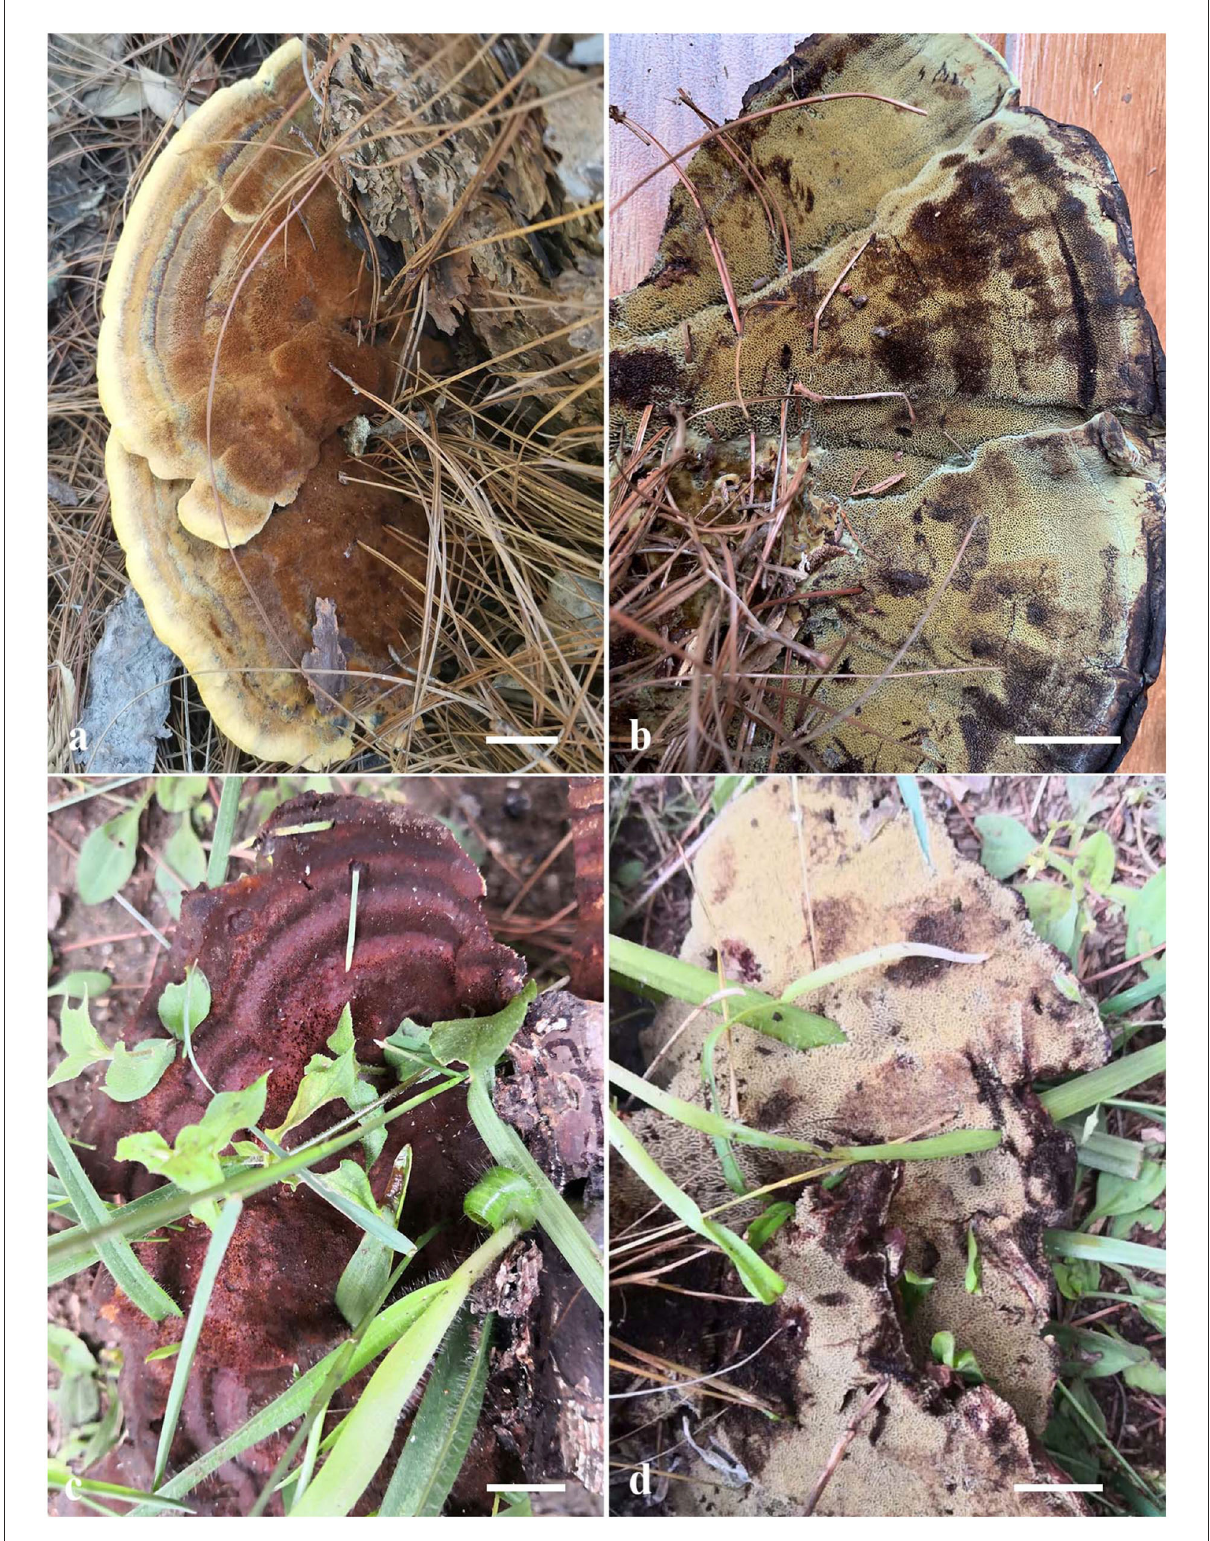
FIGURE4 Basidiocarps of Phaeolus yunnanensis. (a,b) Dai 20426 (holotype); (c,d) Dai 22528. Scale bars =